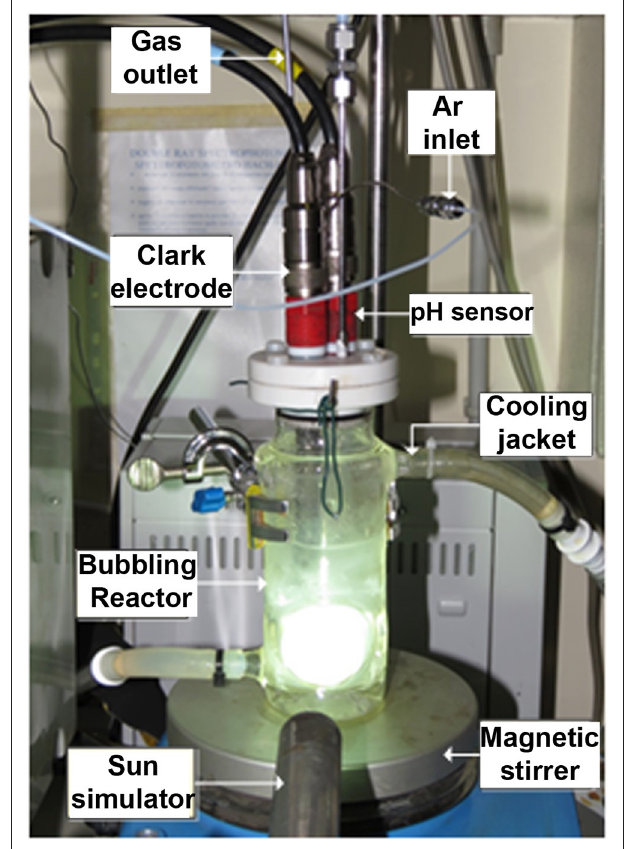
FIGURE 1 | Photocatalytic bubbling reactor used for the water oxidation